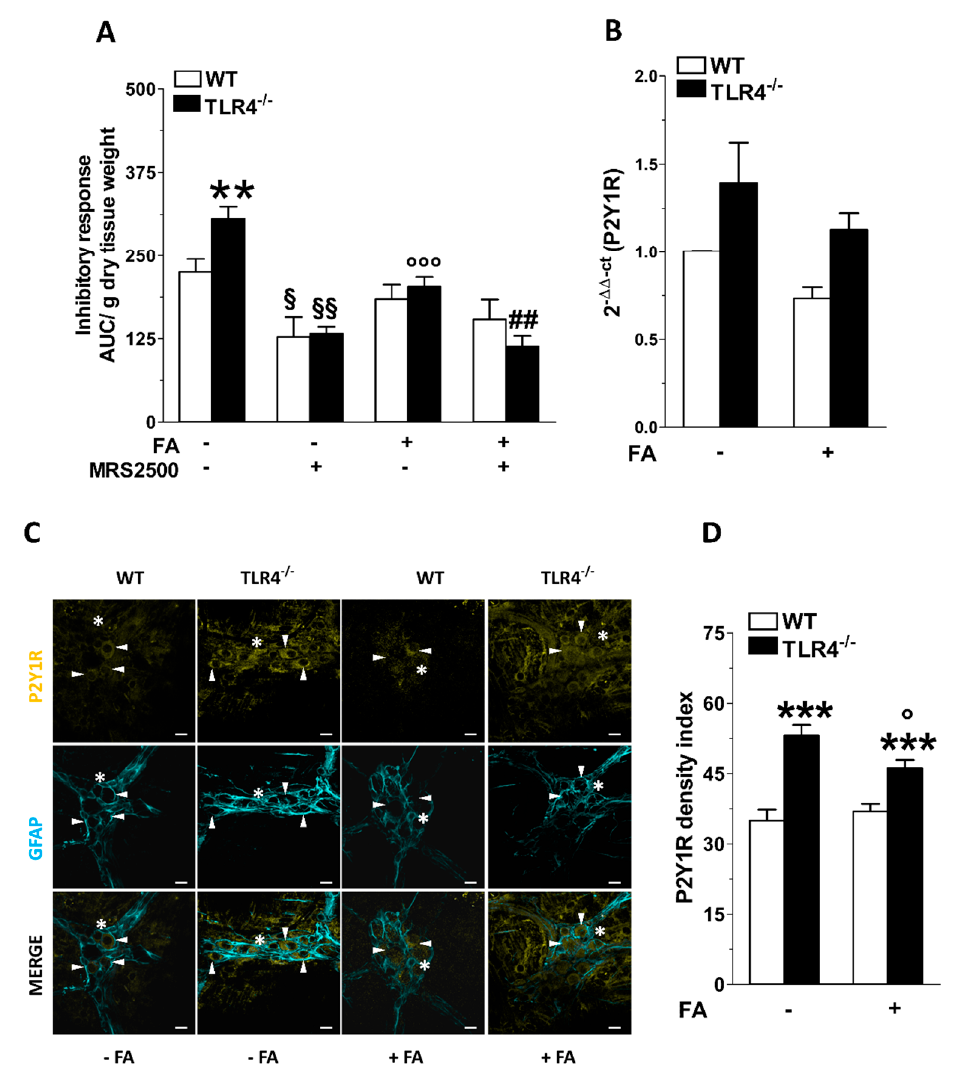
Figure 5. TLR4 signaling and EGC activity affect P2Y1 receptor-mediated small intestinal relaxation.